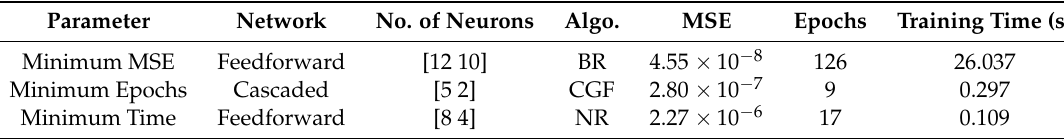
Figure 8. Training time taken by each model to converge. Table 3. Summary of the best